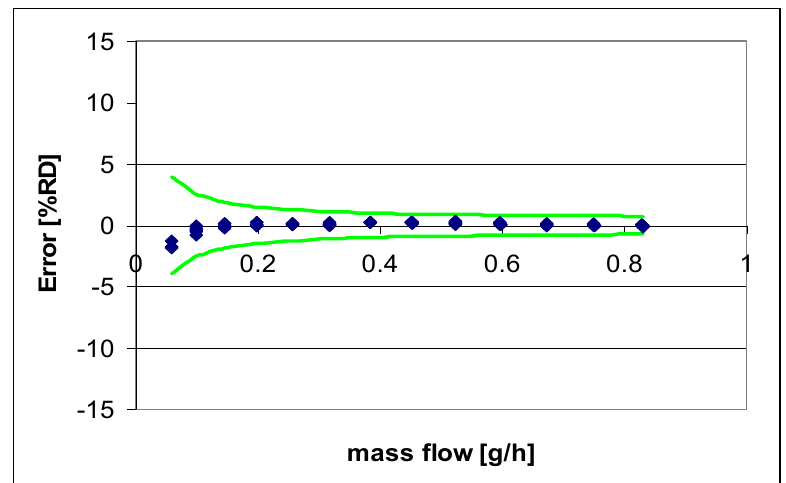
Figure 10. Measured air mass flow vs. piston prover. The envelope represents a zero stability of 2 mg/h and an accuracy of 0.5% reading. The pressure drop across the Coriolis mass flow meter was approximately 8